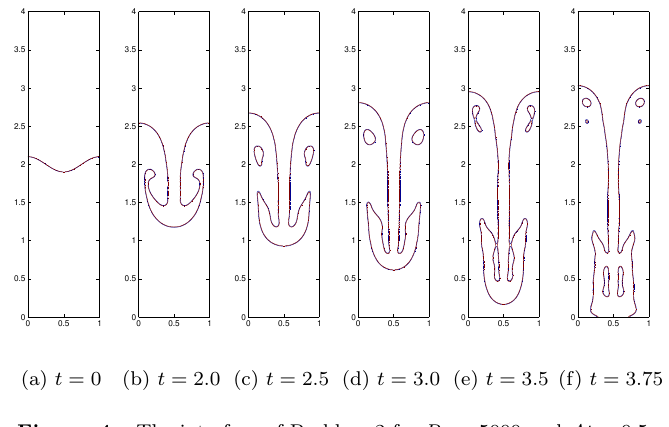
Figure 4. The interface of Problem 2 for Re = 5000 and At = 0 .